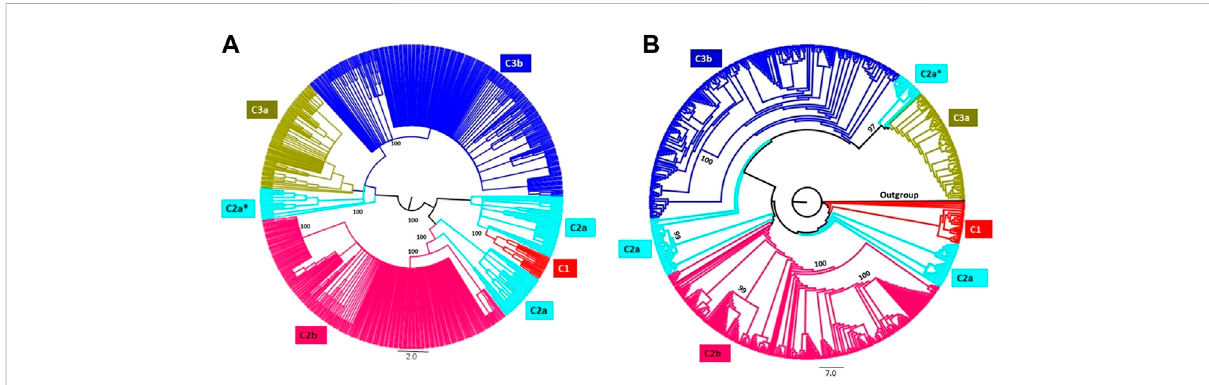
FIGURE 2 Phylogenetic treeanalyses ofVHSVisolates.Thephylogenetictreewasconstructed basedontheanalysisofVHSV G -geneusingtheneighbor- joining (NJ) (A) and maximum likelihood (ML) (B) methods. The clades of the tree are colored according to the STRUCTURE result at K = 5. The admixedstrainsarerepresented withC2a*.Thebootstrapvaluesfor 1,000replicatesareshown inbold characters formajor branches.Thebranches of the tree are colored to represent the fi ve subpopulation clusters.